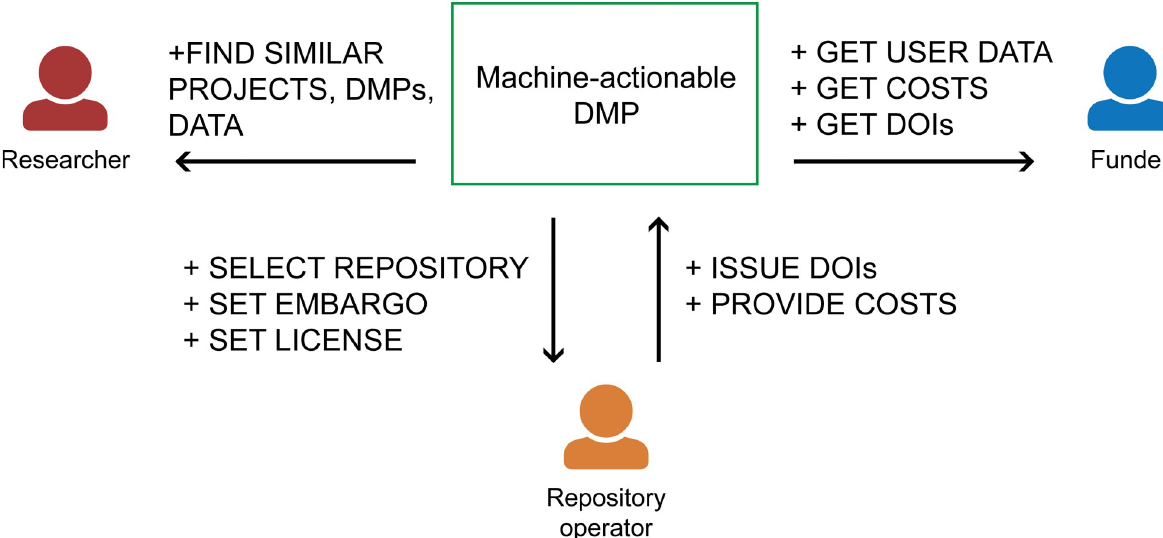
Fig 3. Stakeholder interactions. Examples of stakeholder interactions within the ecosystem of maDMPs. Stakeholders communicate with each other by exchanging information through DMPs. For example, a repository operator can select a proper repository, set an embargo period, and assign a correct license to data submitted by researchers. In return, a system acting on behalf of a repository operator provides a list of DOIs assigned to the data and provides information on costs of storage and preservation. This in turn can be accessed by a funder to check how the DMP was implemented. Researchers can browse DMP catalogues using a variety of filters that allows them to discover projects using similar methodologies or infrastructure or producing similar outputs. DMP, data management plan; DOI, digital object identifier; maDMP, machine- actionable